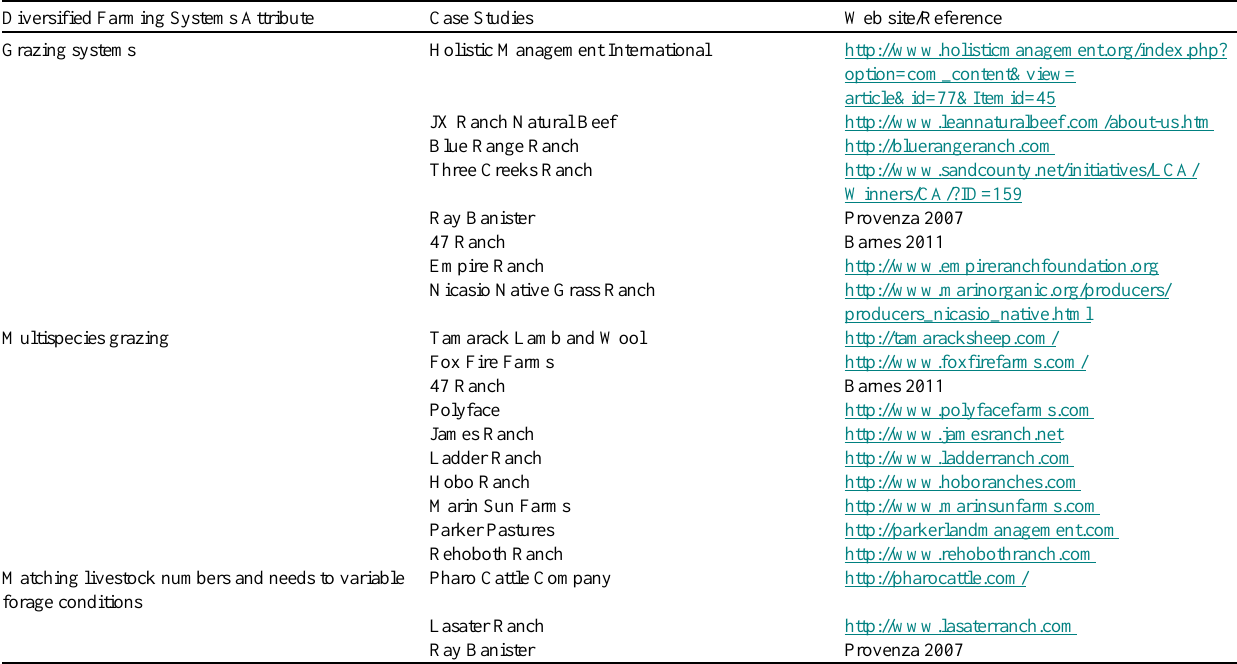
Table 1 . Diversification through innovative management